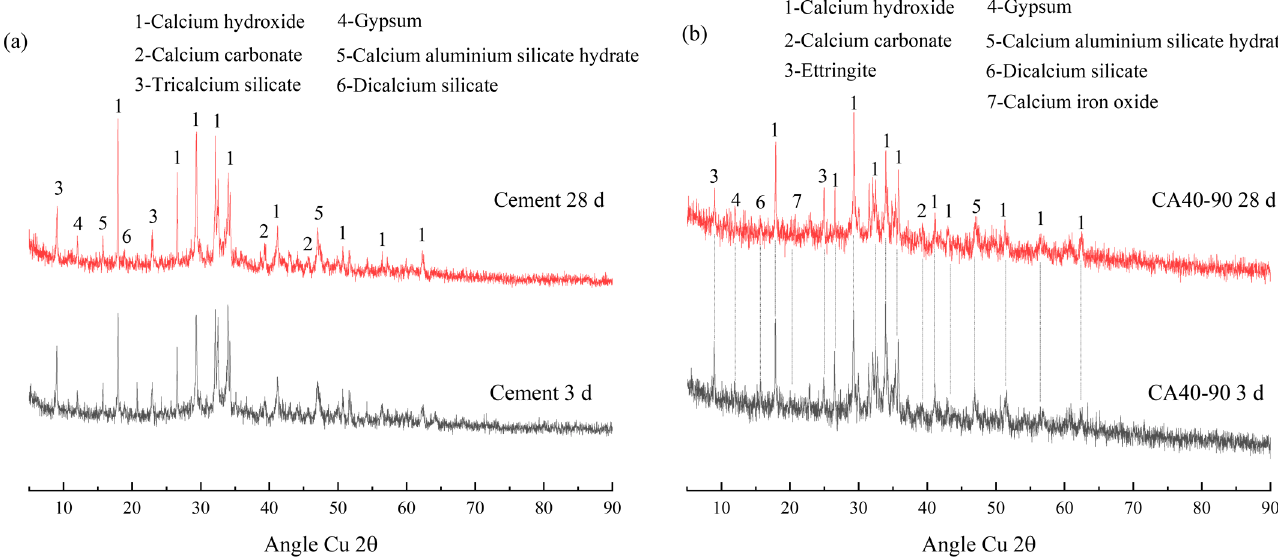
Figure 8. XRD patterns of samples at 3 and 28 d. ( a ) Cement; ( b ) CA40-90.